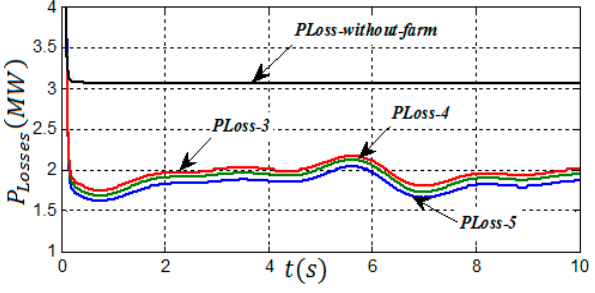
Figure 14. Active power losses in the network before and after integration of the wind farm.